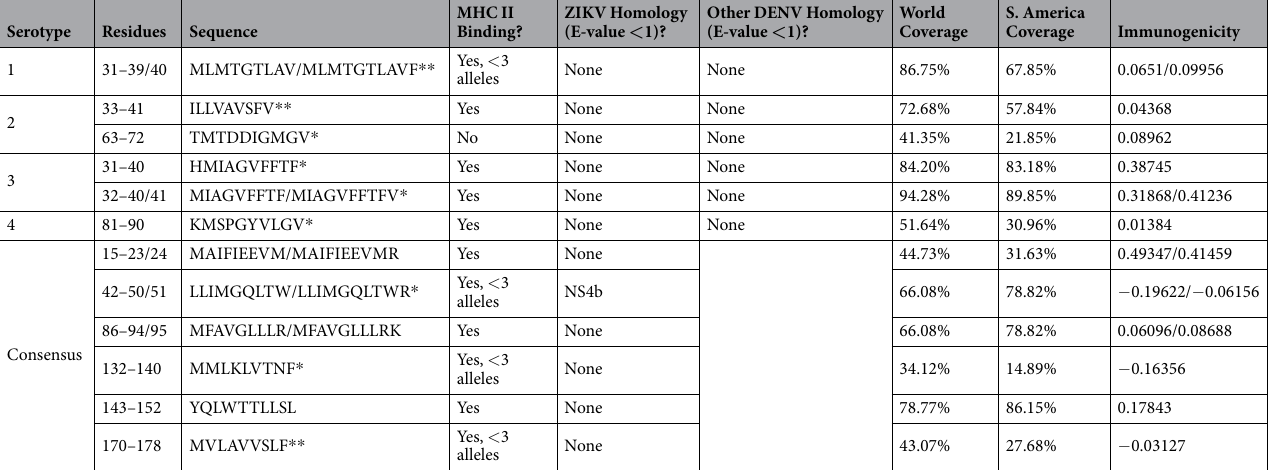
Table 2. Predicted DENV NS2a epitopes for DENV1-4 and consensus DENV NS2a sequence. * Exact MHC-NP match. ** Near MHC-NP match. Immunogenicity > 0 is the threshold for predicted